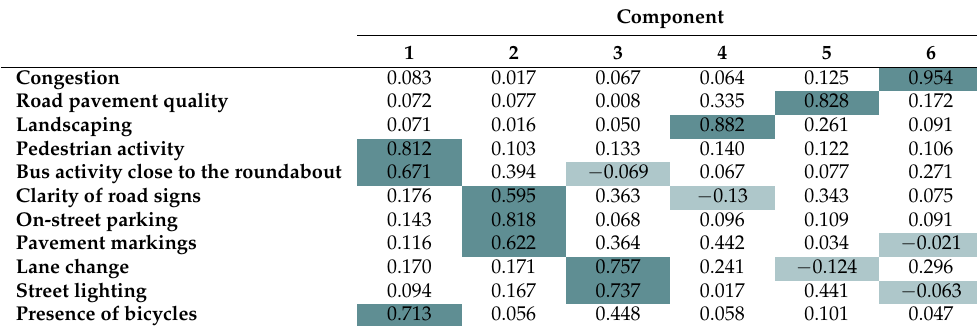
Table 4. Rotated component matrix of scores of QOS factors to the generated components.